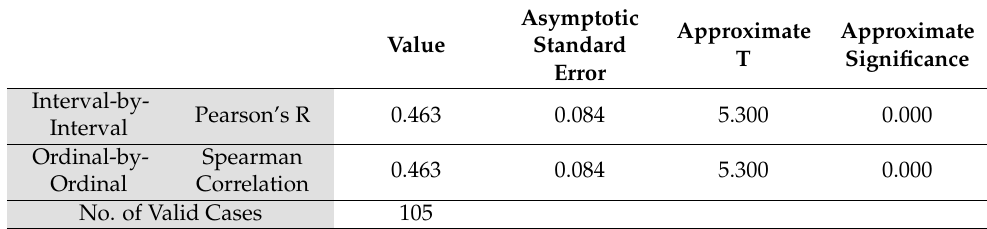
Table 2. Statistical significance of the results.